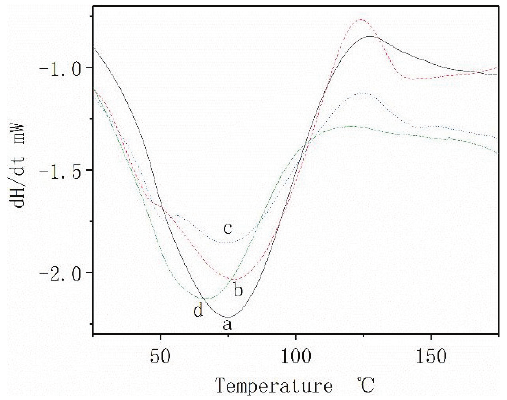
Figure 5: DSC curves of: a – pure copolymer P (2VPco1MA), b – P (1VPco1MA), c – P (1VPco2MA), d – composite film PWA/P